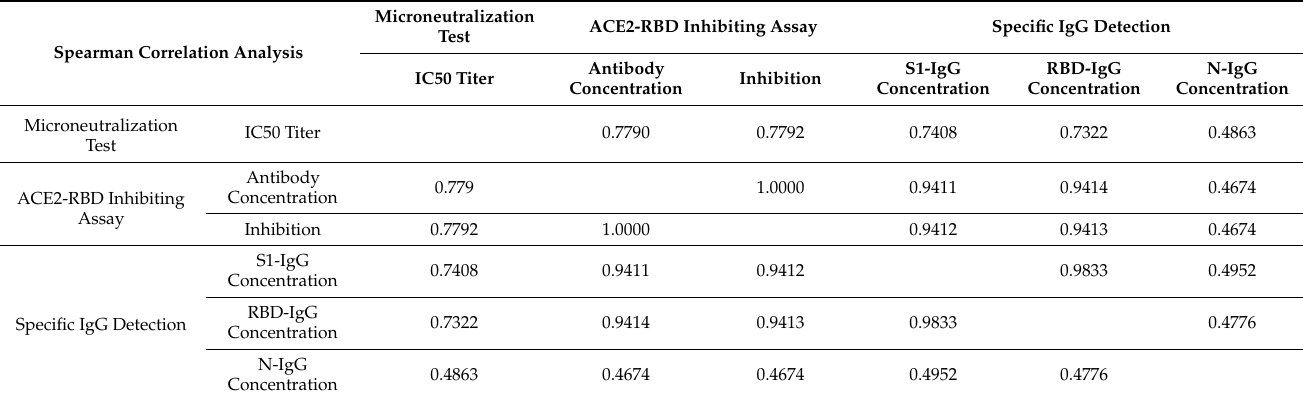
Table 2. Correlation among ACE2-RBD inhibiting antibody, SARS-CoV-2 specific IgG and microneutralization test results of the sera from 86 vaccinated